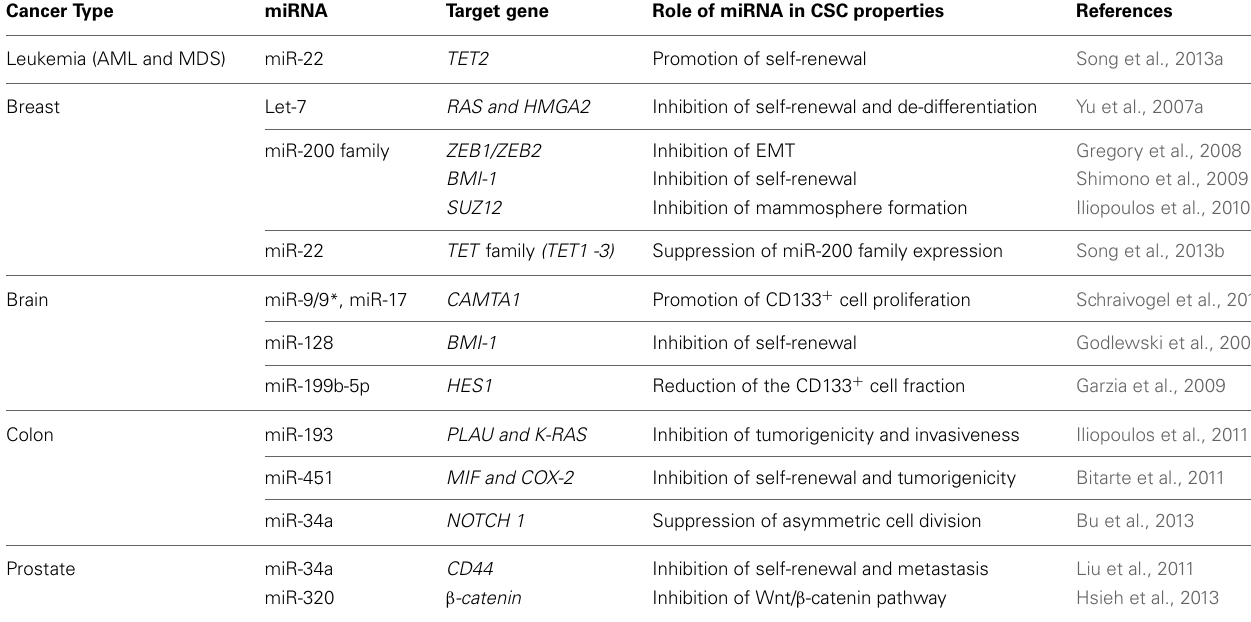
Table 2 | The regulatory roles of miRNAs in